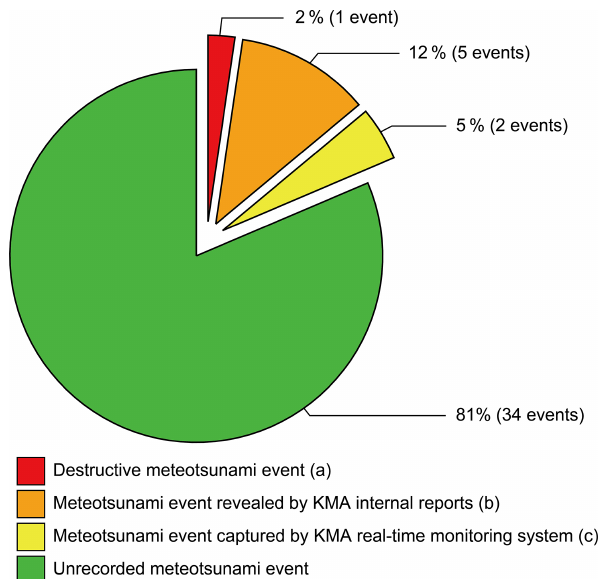
Figure 4. Percentage of meteotsunami event types.